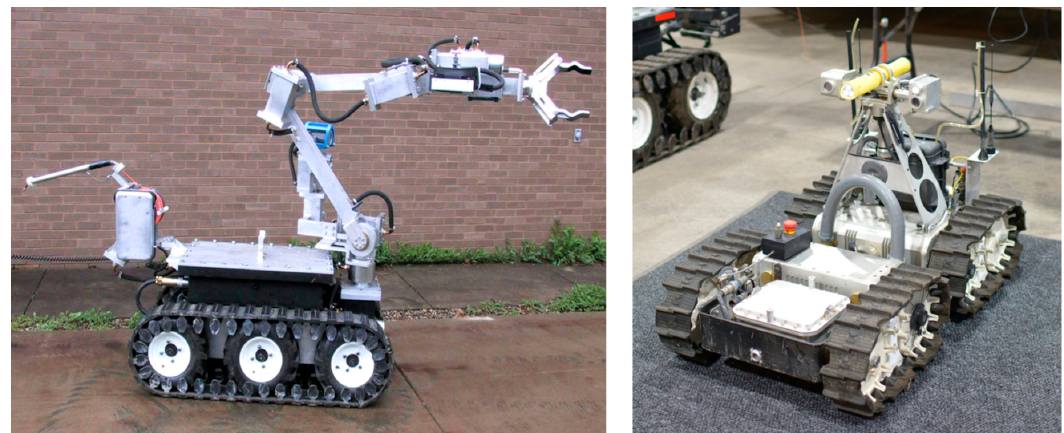
Figure 2. Wolverine V-2 robot developed by Remotec (left) and Gemini-Scout (right).